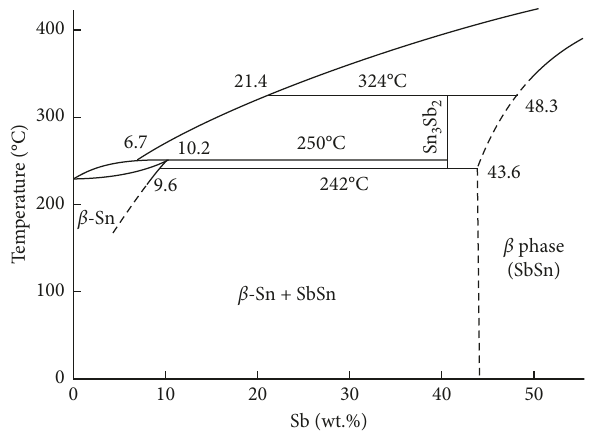
Figure 5: Sn-Sb binary phase diagram [17].